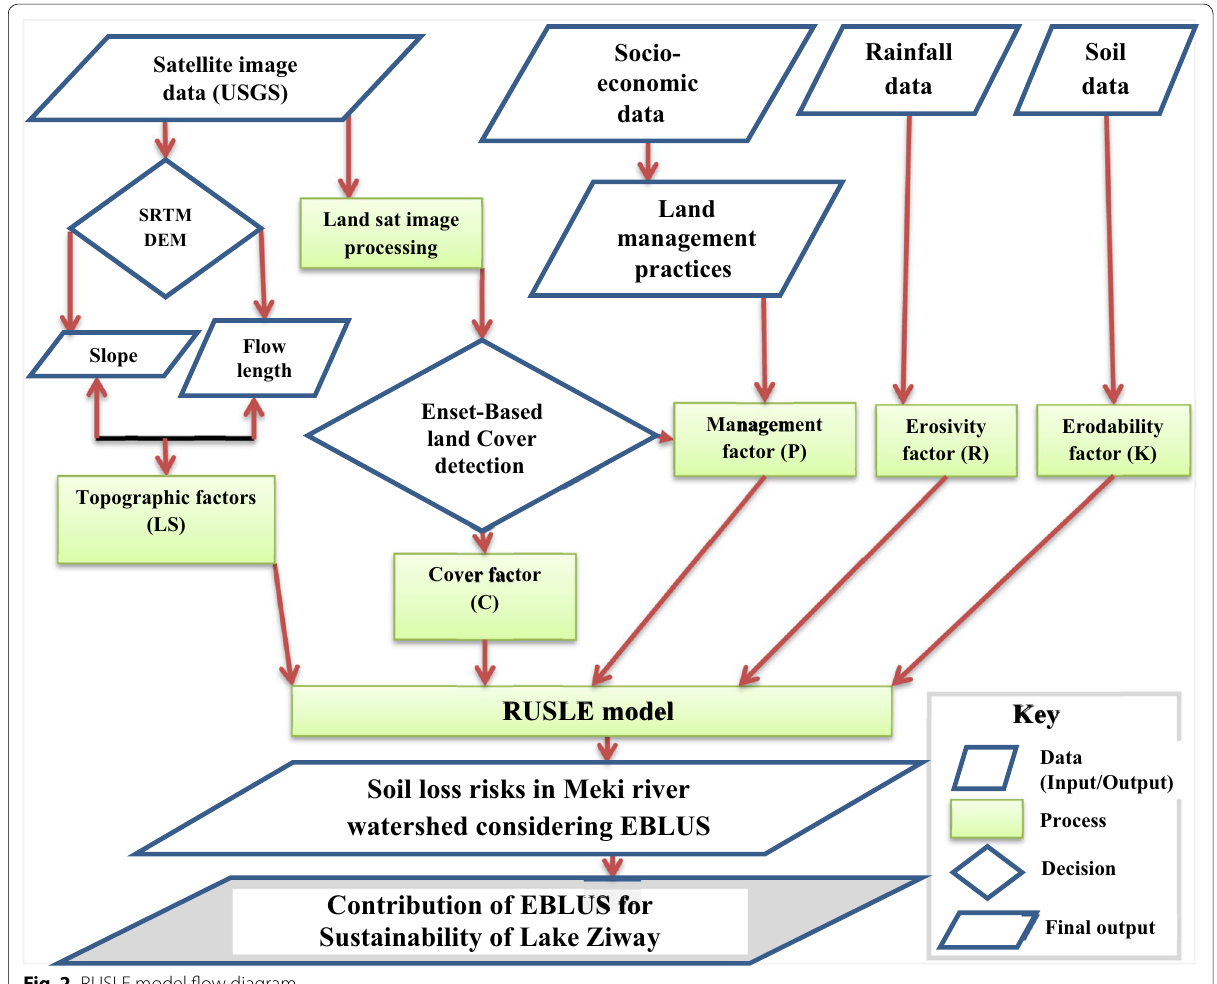
Fig. 2 RUSLE model flow diagram